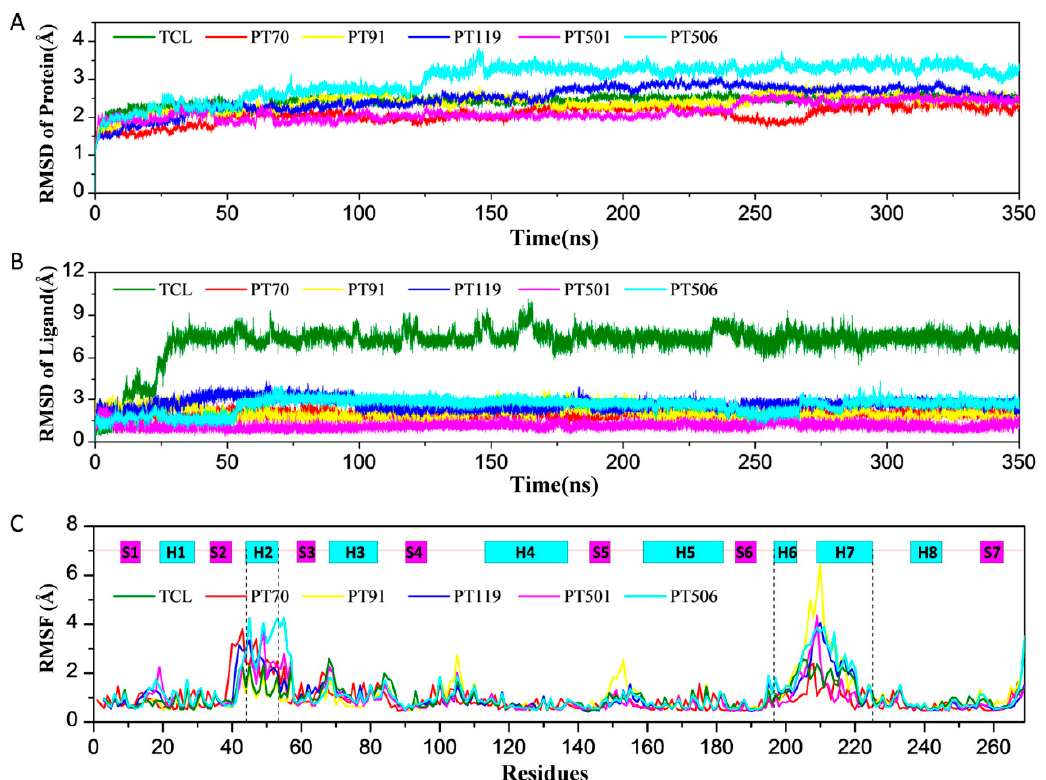
Figure 1. ( A ) Time evolution of the RMSD values of the protein. ( B ) Time evolution of the RMSD values of the heavy atoms of ligands. ( C ) The RMSF values of the protein.